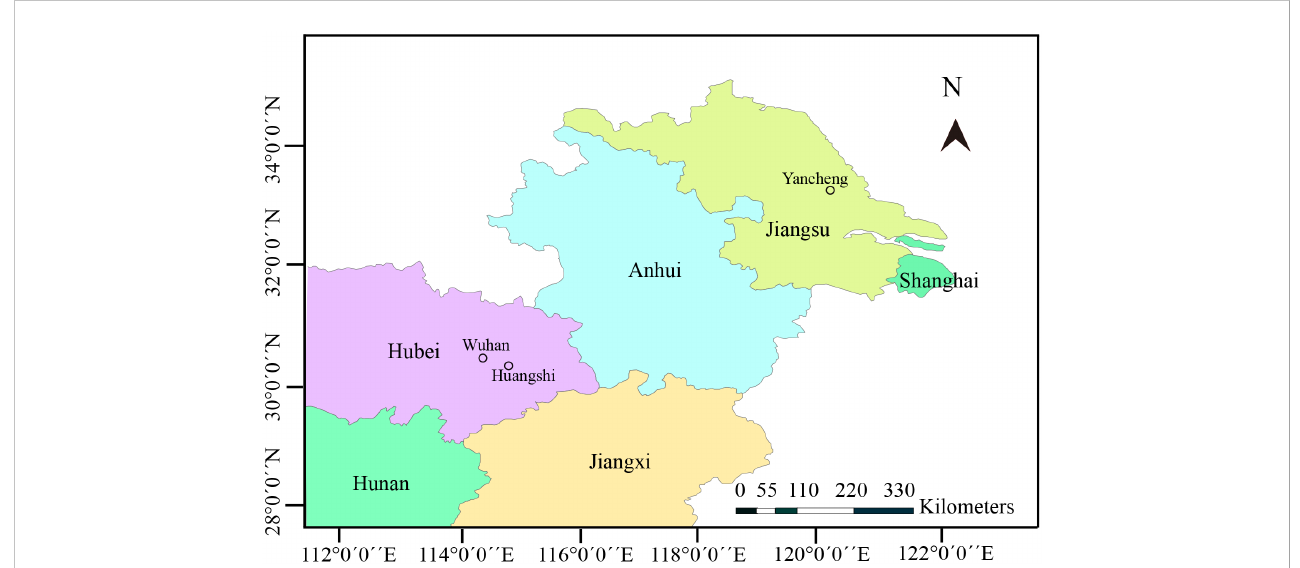
FIGURE 1 Map of partial China, showing geographical locations of sample